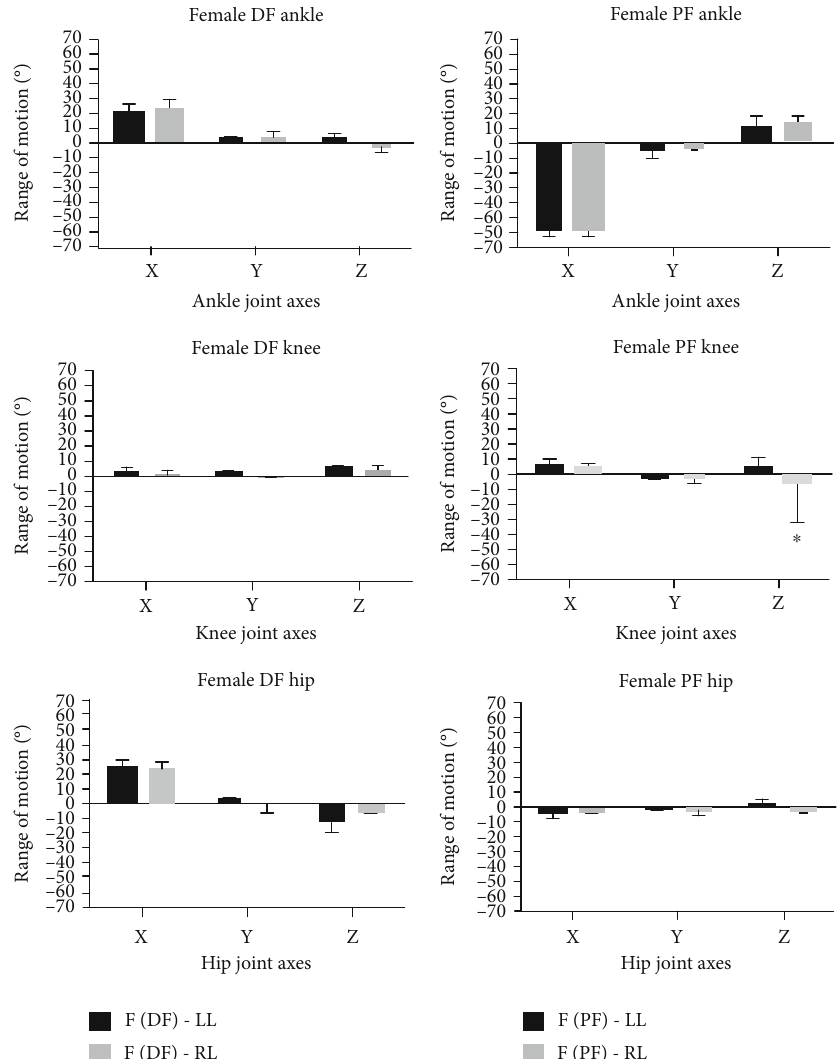
Figure 5: Grouped bar chart representation showing dorsi fl exion (DF) and plantar fl exion (PF) position comparisons between the left limb (LL) and right limb (LL) in female (F) participants at the anterior/posterior ( X ), medial/lateral ( Y ), and vertical ( Z ) directions at the ankle, knee and hip joints. Error bars included ± standard deviation whilst ∗ indicates statistical signi fi cance ( p < 0 : 05 ) ( n = 10